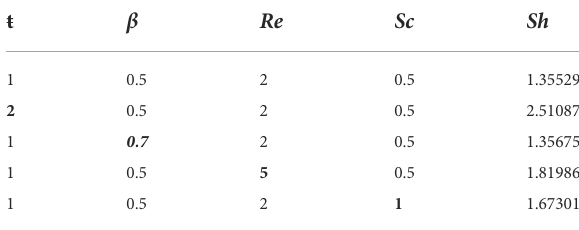
TABLE 3 The behaviour of the Nusselt number with the variation of parameters on the left plate.